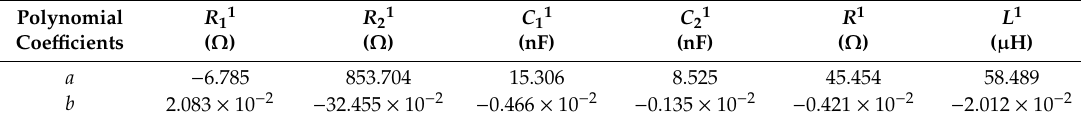
Table 9. Linear parameters for MT6 pi-circuit as a function of soil resistivity.